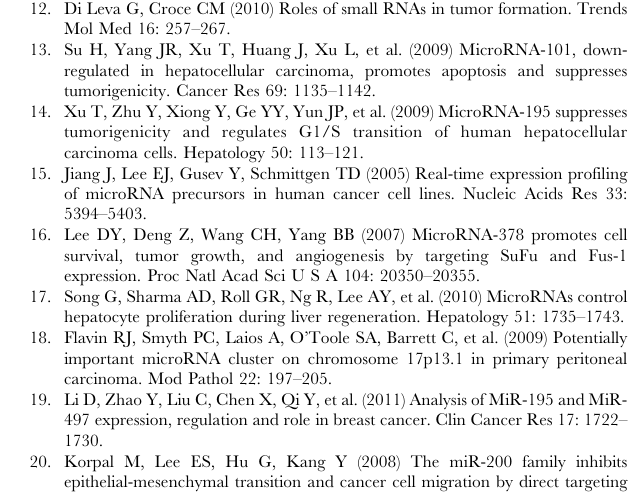
rates, which show maximum negative enrichment scores (8 and 36% for miR-195 and miR-497 experiments, respectively). Figure S5 Representative results of Western blotting of CDK4, CCNE1, CCND3, CDC25A, and BTRC 48 hours after trans- fection with each specific siRNA or negative control (siNC).